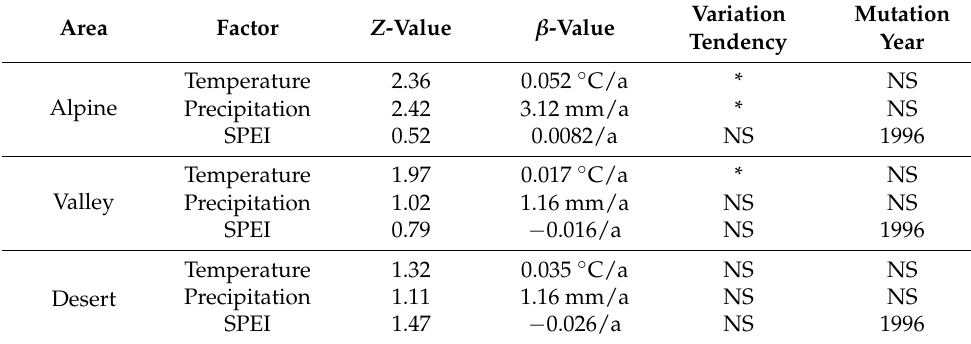
Table 2. Characteristics of interannual variation of climatic